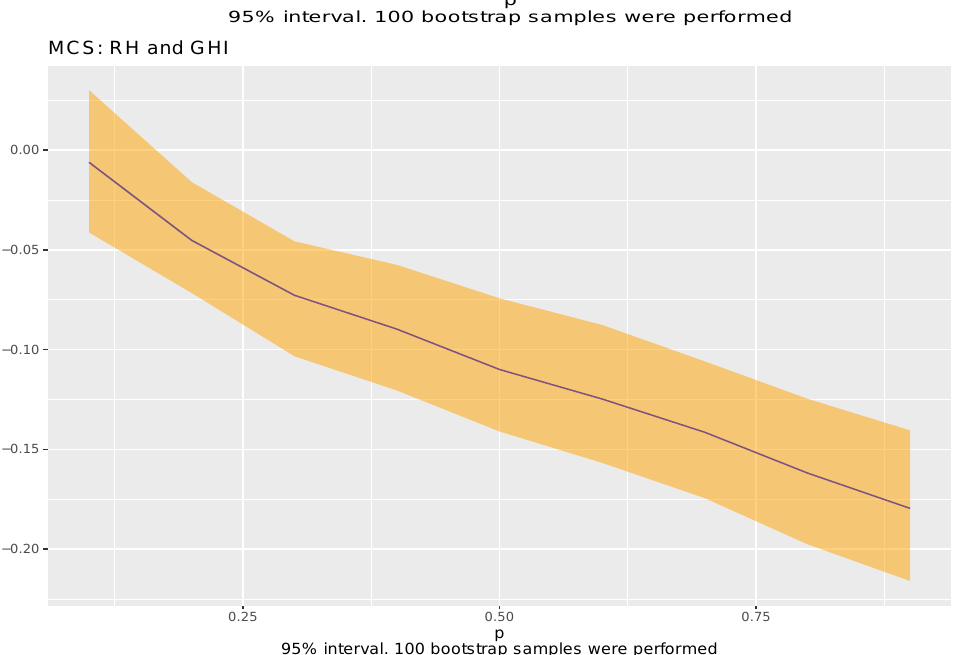
Figure 6. MCS plots with associated 95% bootstrap confidence